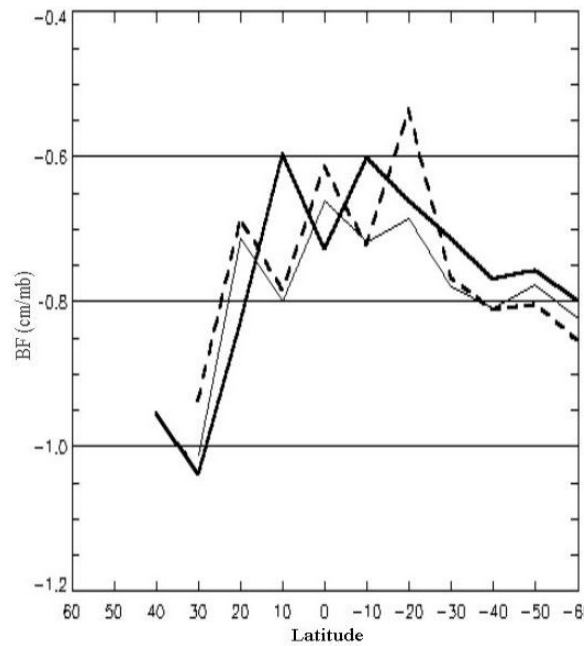
Fig. 4. As Fig. 2, in the case of the Indian